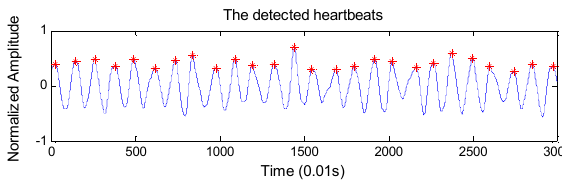
Figure 4. The detected heartbeats based on the 5th approximation layer of the BCG signal.